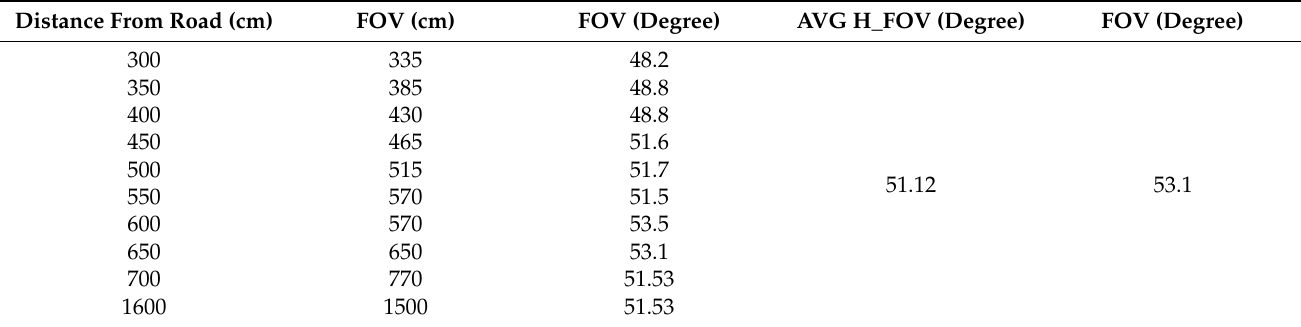
Table 4. Outdoor Field Of View (FOV) measurement for various distances from the road, Average Horizontal Field Of View (AVG H_